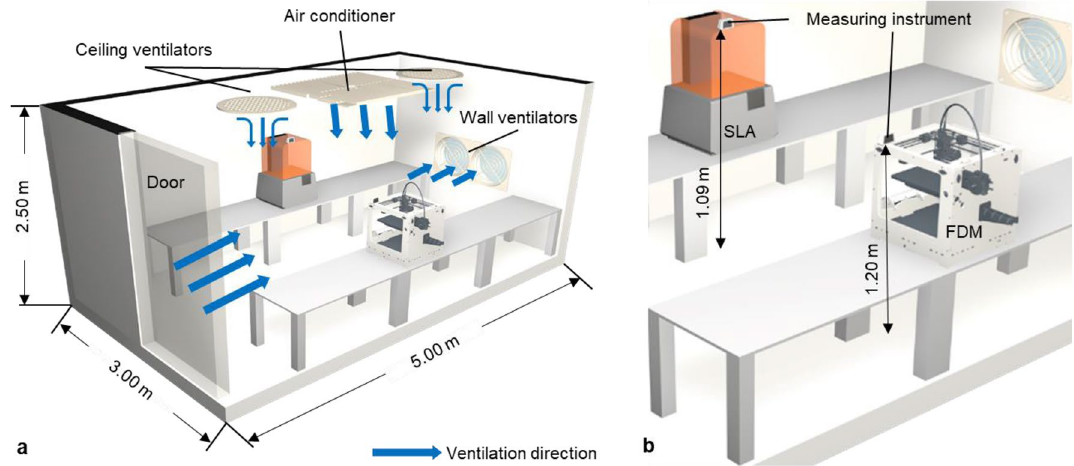
Figure 1. HYPERLINK "sps:id::fig1||locator::gr3||MediaObject::0" The 3D printing (3DP) workspace with ventilation facility. ( a ) The layout of the 3DP workspace. ( b ) The location of